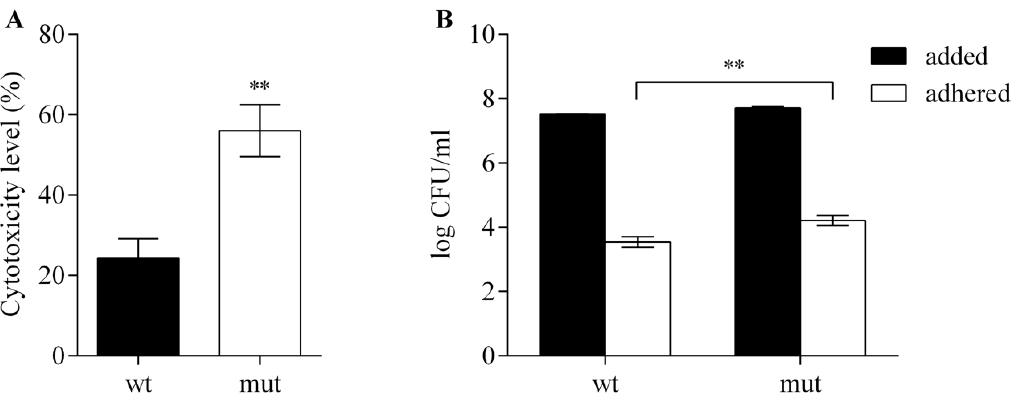
Figure 7. Cytotoxic effect and adhesion ability of WCS358 wild type and ∆ rclS mutant using HaCaT keratynocite cell line as a model system. ( A ) Cytotoxicity level (%) of wild type and ∆ rclS mutant measured by LDH assay was expressed relative to negative control (0%). ( B ) Adhesion ability of wild type and ∆ rclS mutant was expressed as a ratio of adhered bacteria relative to added bacteria (log CFU/mL). The results are represented as mean values ± standard deviations for three biological replicates. Student’s t -test was employed to compare differences between wild type and ∆ rclS mutant (** p < 0.01).